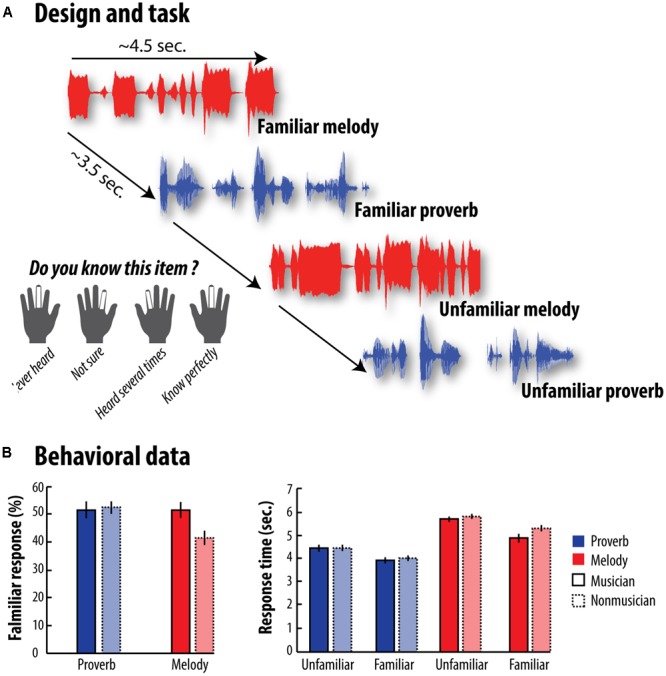
Design and Behavioral results - (A) We recorded participants’ brain activity while they performed the familiarity task. After listening either to melodies or to French proverbs, they had to rate their familiarity level on a 4-point scale by pressing buttons under their fingers. (B) The left-hand graph shows the percentage of French proverbs and melodies judged to be familiar by both musicians and non-musicians. The right-hand graph shows response times in each category for the two groups. Error bars represent the standard error of the mean (SEM). Statistical analyses are reported in details in the main text. Overall, musicians rated more melodies as familiar than non-musicians did (this difference was absent for French proverbs). Furthermore, we found that musicians judged more quickly melodies as familiar compared to non-musicians, while this effect was not observed for unfamiliar melodies or proverb in general.